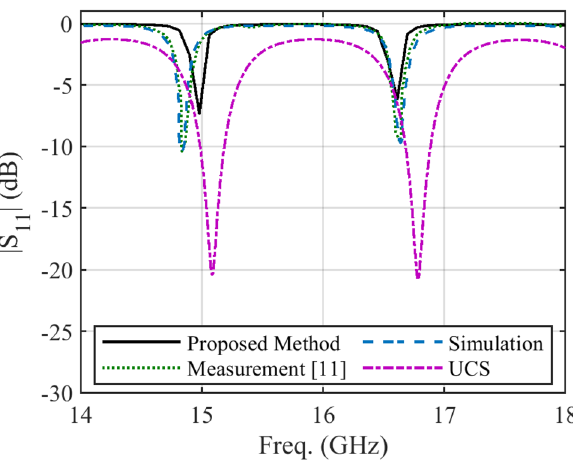
Figure 10. Magnitude of S 11 of the linearly-tapered